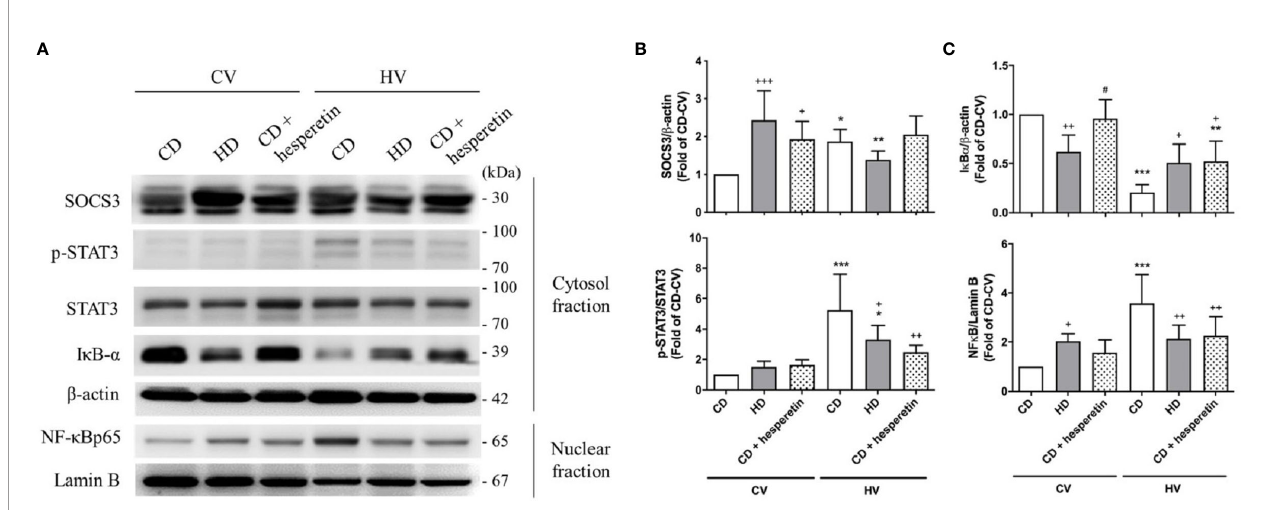
FIGURE 4 | Effects of pharmaceutical SOCS3 upregulation on the STAT3 – SOCS3 and NF- k B signaling pathways. These parameters were collected in nonobese mice (CD), obese mice (HD), and nonobese mice pretreated with hesperetin enterally (CD + hesperetin) after 6 h of spontaneous breathing (CV) or mechanical ventilation (HV). (A) Western blotting. b -Actin and Lamin B served as loading controls for cytoplasmic and nuclear proteins, respectively. Representative blots are shown. (B) SOCS3 and p-STAT3/STAT3. (C) I k B a and NF- k B. Data are expressed as the mean ± SE (n = 5 per group). * P < 0.05, ** P < 0.01, and *** P < 0.001 compared with the corresponding group in the CV condition. + P < 0.05, ++ P < 0.01, and +++ P < 0.001 compared with the nonobese mouse group (CD). # P < 0.05 compared with the obese mouse group